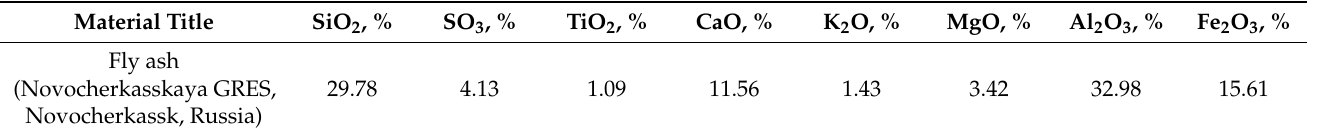
Table 5. Chemical composition of fly ash.